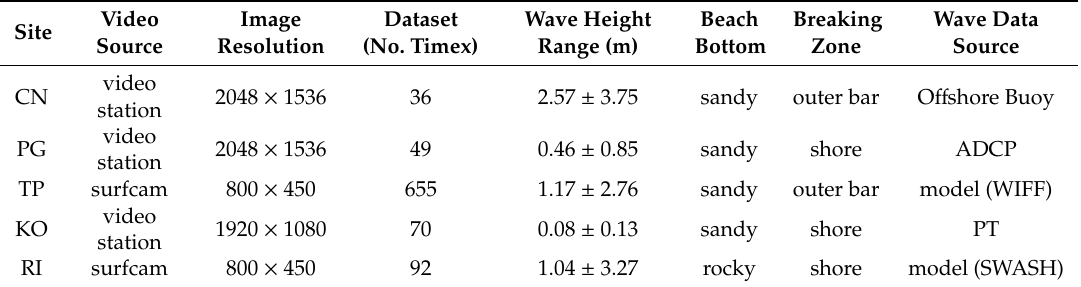
Table 1. Video system, beach characteristics, and wave conditions observed during the experiments for each study site, namely CN (Costa Nova), PG (Praia Grande), TP (Tarquinio-Paraiso), KO (Kourou), and RI (Ribeira d’Ilhas, development site).